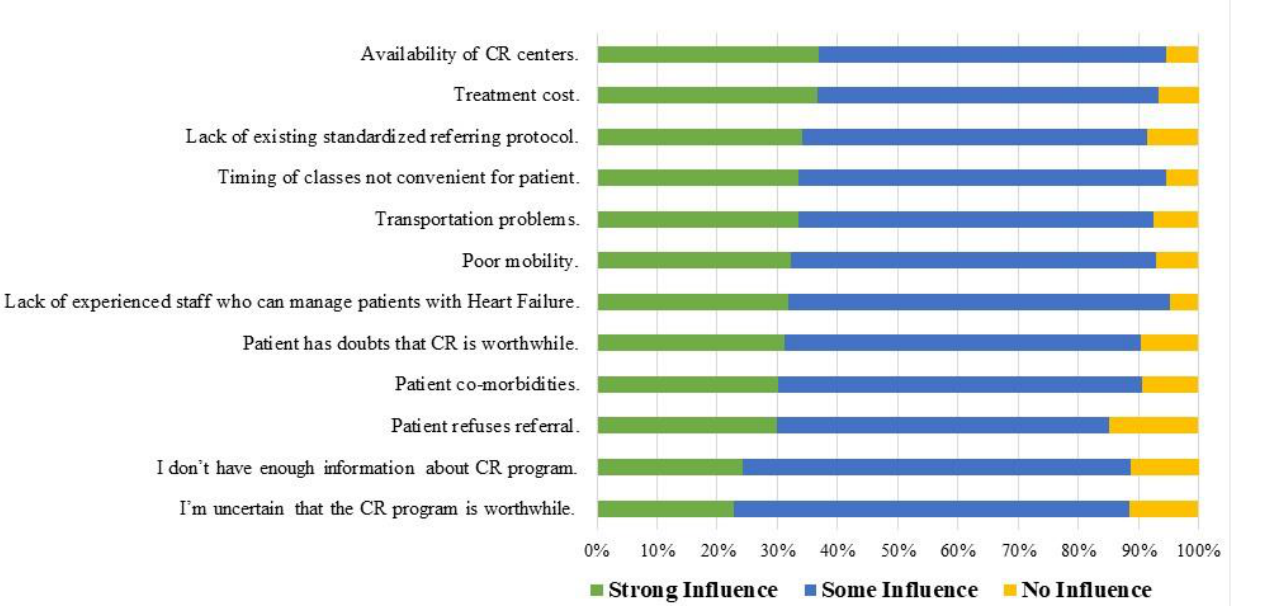
Figure 2 . Barriers to not referring patients with Heart Failure to cardiopulmonary rehabilitation, using influence graded as no, some, or strong influence ( n = 439).